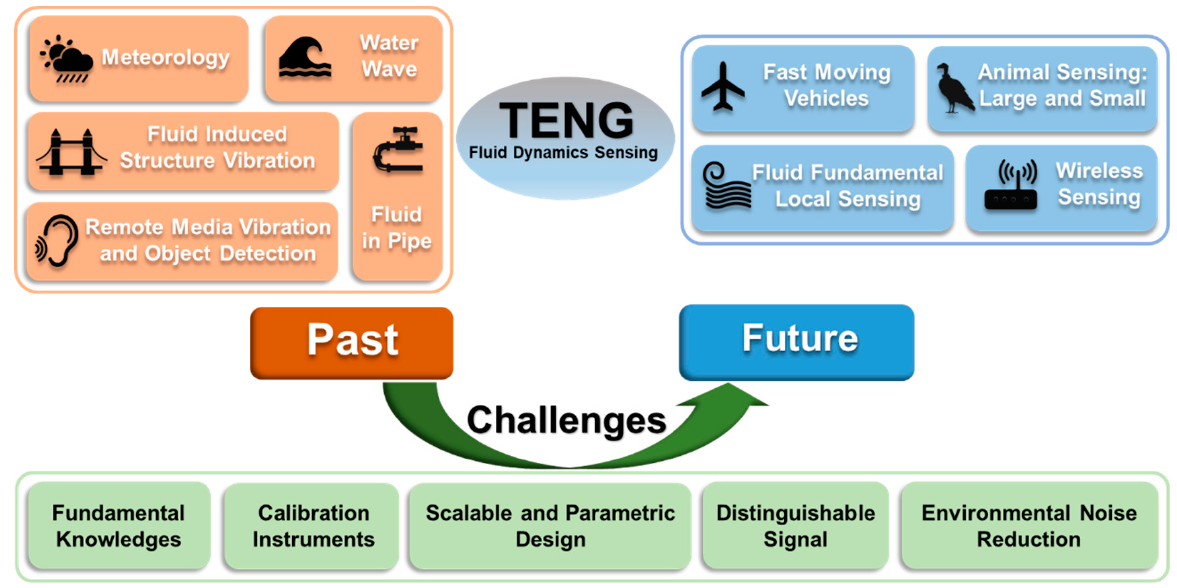
Figure 1. Opportunities and challenges of triboelectric nanogenerators for fluid dynamics sensing, from traditional fields to future technologies.